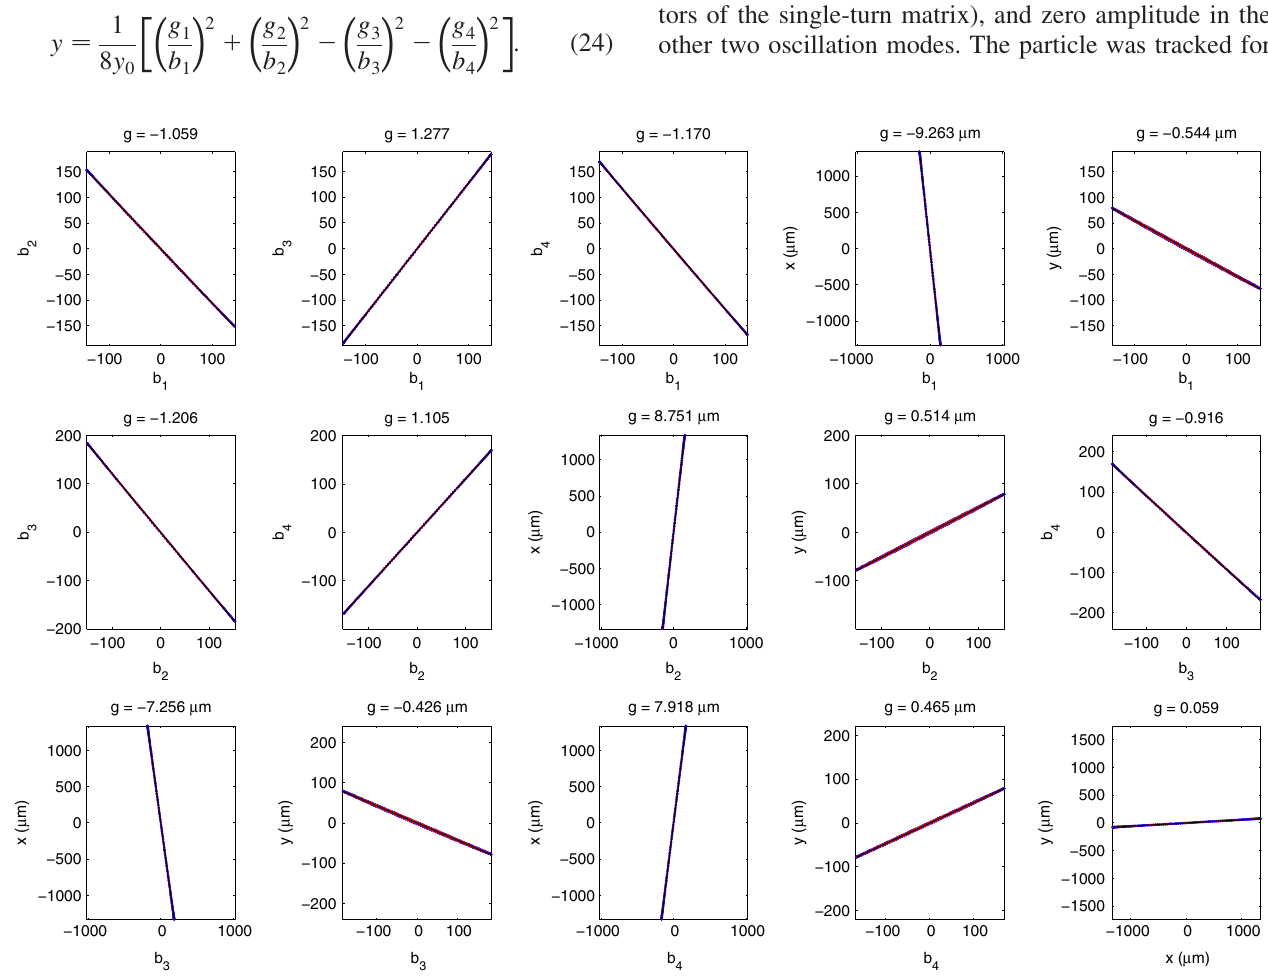
FIG. 3. Simulation of turn-by-turn button signals on a BPM (7W). Each plot shows a correlation between two BPM button signals or beam coordinates (returned by the BPM), obtained by tracking a bunch performing coherent oscillations in normal mode I. An ideal model (with no errors) of the CesrTA lattice is used: tracking data are shown as blue points; fitted ellipses are shown in red; the major axes of the ellipses are shown as black lines. The ellipses are more clearly visible when coupling is present (see Fig. 4). Button signals are calculated using Eq. (21), with relative gain errors applied to the buttons as follows: g 2 =g 1 ¼ 1 : 063 , g 3 =g 1 ¼ 1 : 282 , g 4 =g 1 ¼ ¼ 20 mm , y ¼ 10 mm . x and y beam coordinates are calculated from Eqs. (23) and (24), 1 : 170 . The button locations are given by x 0 0 but using nominal gain values g 1 ¼ g 2 ¼ g 3 ¼ g 4